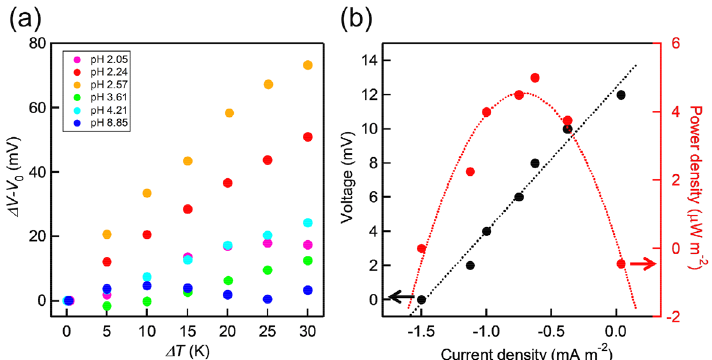
Figure 4. (a) pH dependence of ΔV − V 0 and ΔT of the TEC cell. V 0 is the initial open-circuit potential difference, as shown in Table S2. The initial concentration of pyruvic acid, lactic acid, and sodium sulfate